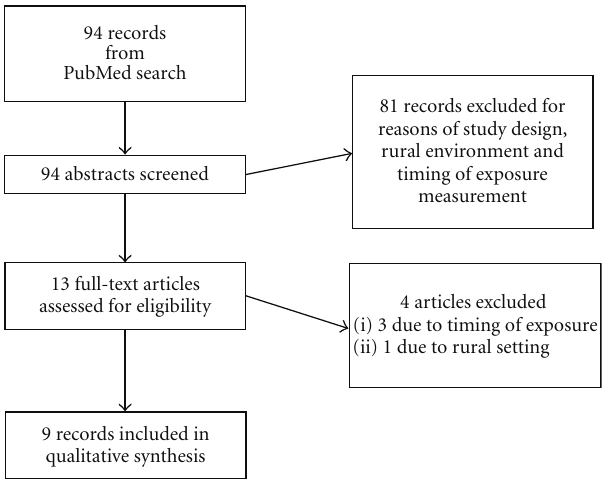
Figure 1: Flow chart of searching